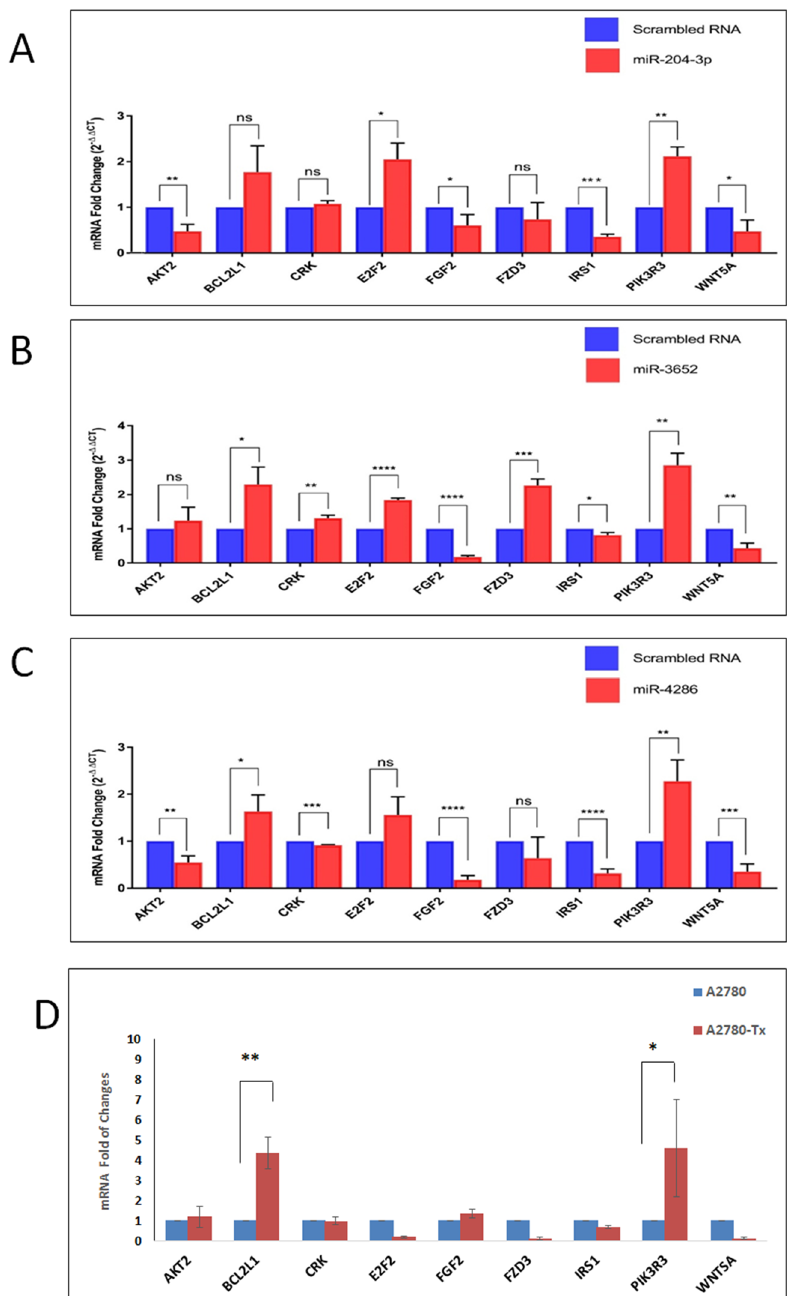
Figure 7. Overexpression of the epigenetically regulated miRNAs affects the expression of predicted downstream targets. qPCR showing variation in expression of miRNAs’ target genes in response to the indicated miRNAs overexpression of ( A ) miRNA-204-3p, ( B ) miRNA-3652, and ( C ) miRNA-4286 in KF-Tx. ( D ) qPCR showing diffrencial expression of the same miRNAs’ target genes in A2780 cells and A2780-Tx cells. The results are means ± SE from independent triplicates (* p < 0.05, ** p < 0.01 and *** p < 0.001) as obtained from